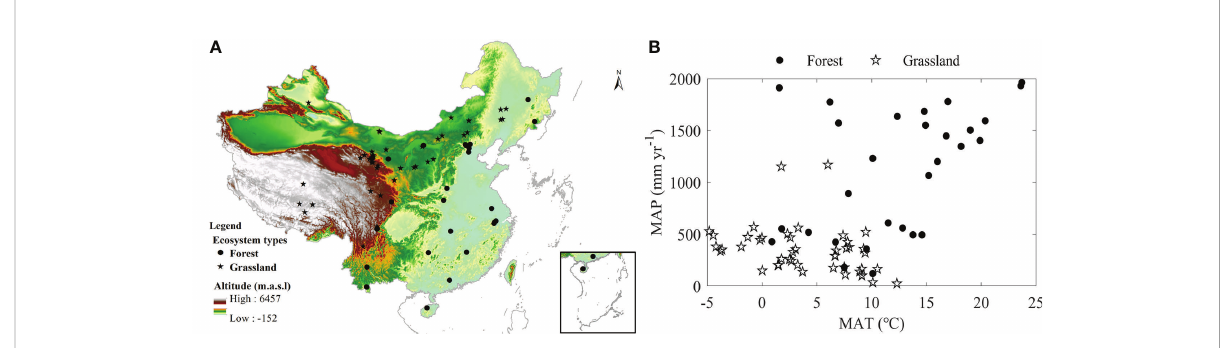
FIGURE 1 Spatial distribution (A) and Climate distribution (B) of ecosystems used in this